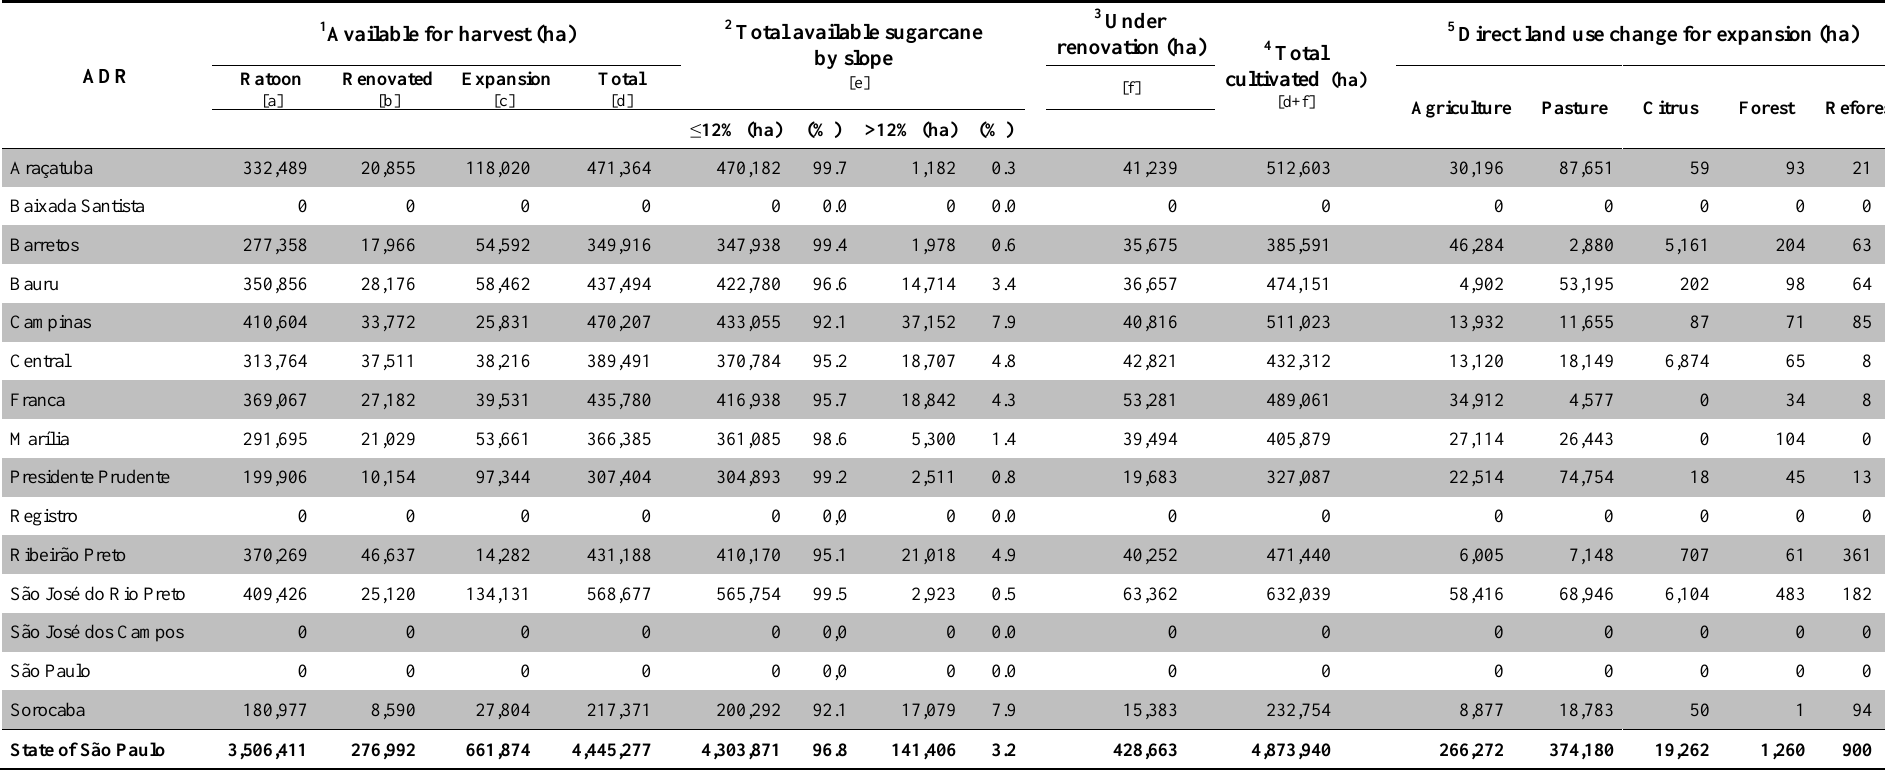
Table 1. Information on sugarcane cultivated area for the Administrative Regions (ADRs) of São Paulo state, crop year 2008/09: (1) cultivated area available for harvest; (2) cultivated area by terrain slope; (3) cultivated area under renovation; (4) total cultivated area; and (5) direct land use change for cultivated area of sugarcane